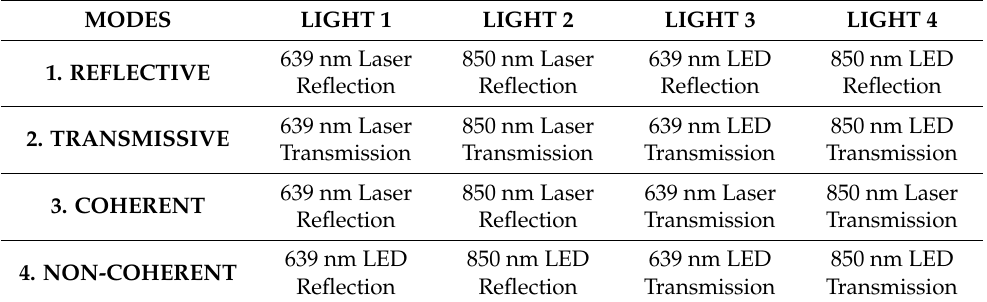
Table 1 lists the 4 experimental modes with their 4 respective illumination settings. Table 1. Experimental modes and their illumination settings for the 4 video channels. MODES LIGHT MODES